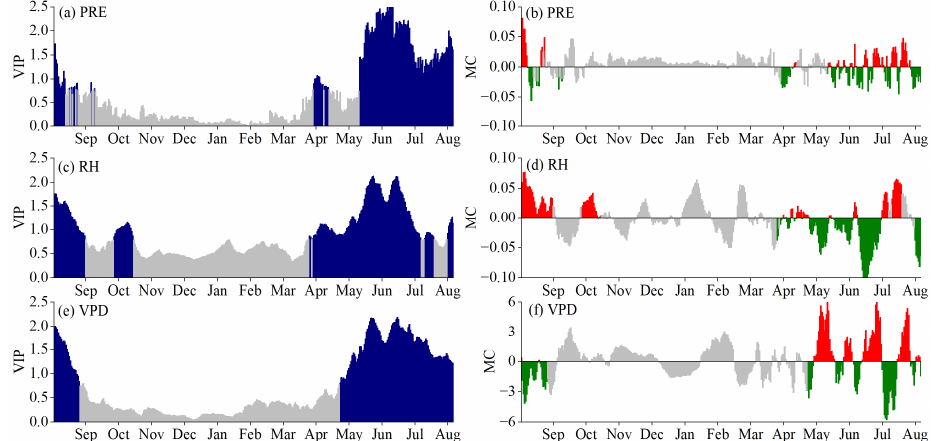
Figure 6. Results of partial least squares (PLS) regression correlating the peak of the growing season (POS) from 1985–2018 with 31-day running means of climatic factors. ( a , b ) Daily precipitation (PRE), ( c , d ) relative humidity (RH) and ( e , f ) vapor pressure deficit (VPD) from the previous September to August of the year.